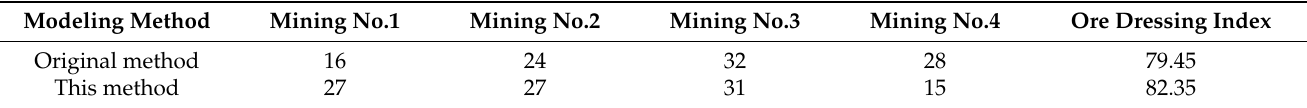
Table 6. Ore blending